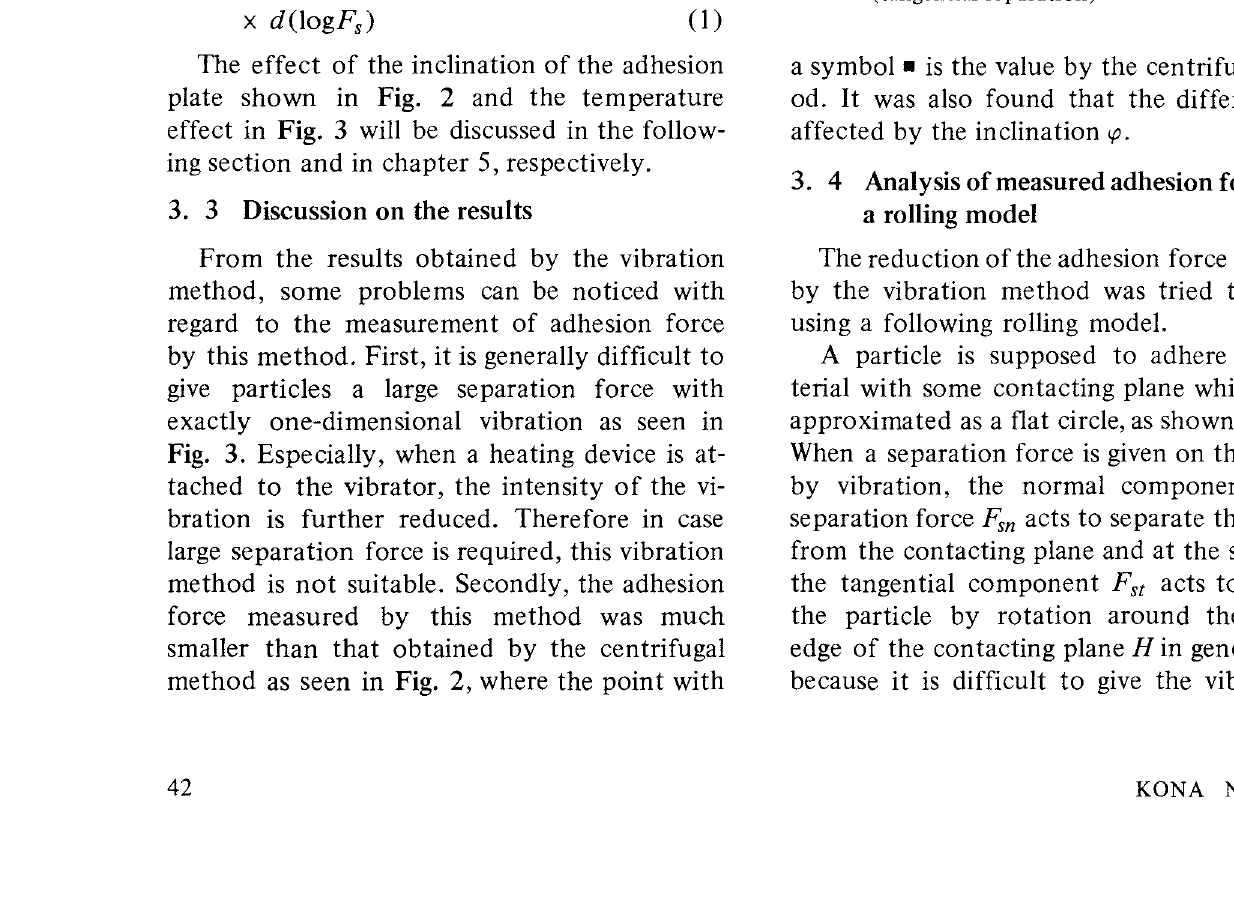
Fig. 3 The results of measurement ofF .C.C. Particles by vibration separation method (tangential